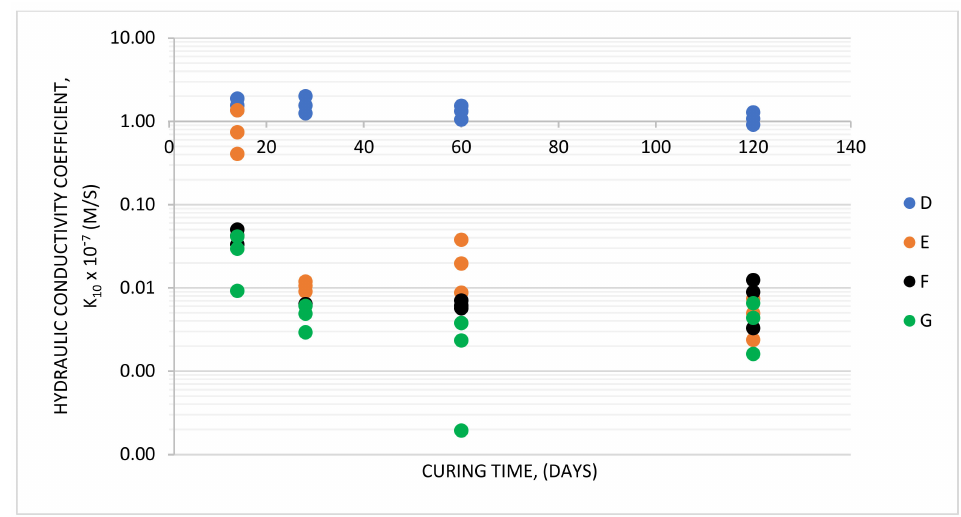
Figure 8. Hydraulic conductivity of slurries D–G in the course of